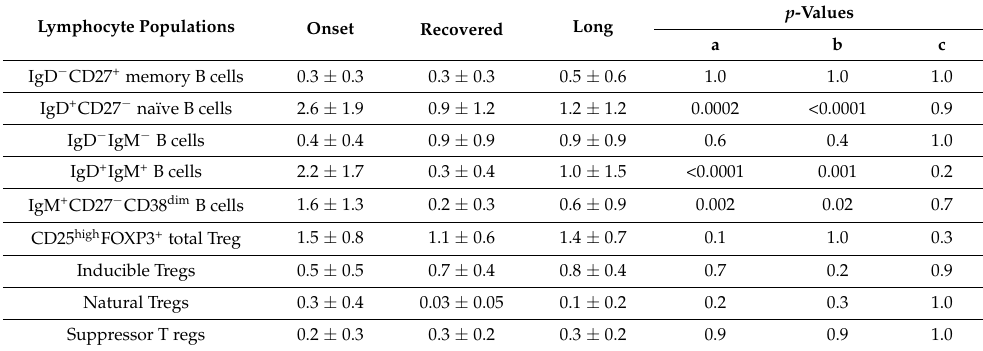
Figure 3. Age-related impact of early/late phases of CoV2 infection on B and Tregs lymphocytes. Gating strategy for the identification of cell subsets is described in Figure 1 and in [21]. Each circle represents the percentage of each cell subset or ratio of the different patients/healthy subjects based on the indicated colors: CoV2 -infected children at onset of the disease (red circles), who recovered (green circles), with persistent symptoms (violet circles) and healthy subjects (white circles). The panel ( A ) displays the distributions of B-cell subpopulations in the cohort of patients/controls older than 6 years; the panel ( B ) shows the percentages of Tregs subsets in children >6 years old. The data were statistically examined using two-way ANOVA corrected with Tukey. Table 3. B and Tregs populations in children older than 6 years. Data refer to Figure 3 extracted percentages (mean ± standard deviation), excluding controls, and p values were calculated applying two-way ANOVA corrected with Tukey: a: comparison among Onset and recovered children; b: comparison among onset and long; and c: comparison among long and